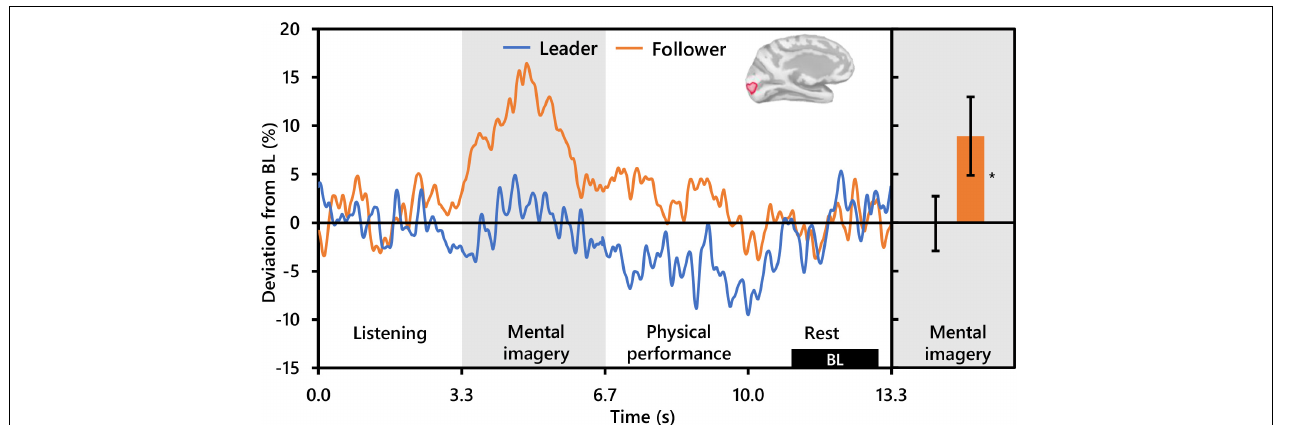
FIGURE 5 | Effect of social role on occipital alpha activity ( N = 20). The time-series waveforms (left) show overall mean alpha (8–13 Hz) activity in the left significant cluster which overlapped portions of the cuneus, pericalcarine, lingual gyrus, and lateral occipital areas (see displayed cortical map) across one communication epoch for Leaders and Followers separately and temporally aligned to facilitate visual comparison. The histogram (right) shows representative overall mean activity over the mental imagery period in the same cluster for each role. BL, baseline period. Error bars are standard error. Asterisk indicates significant differences from 0 based on single-sample t